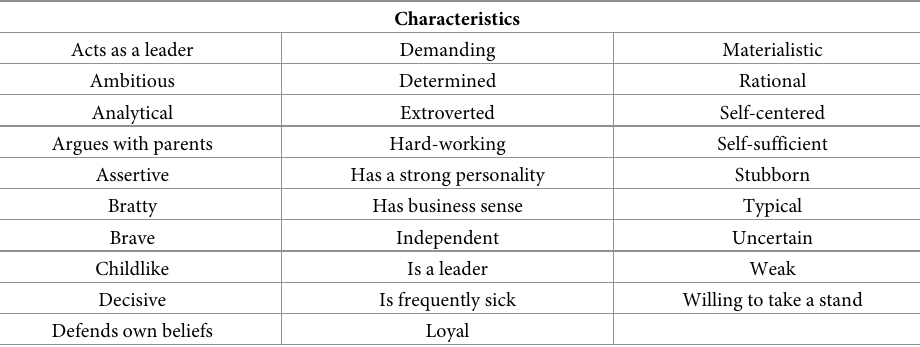
Table 1. Characteristics showing no effect of gender in ratings of